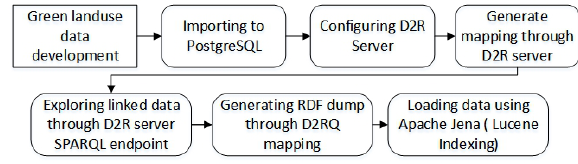
Figure 4. Generating green landuse linked data